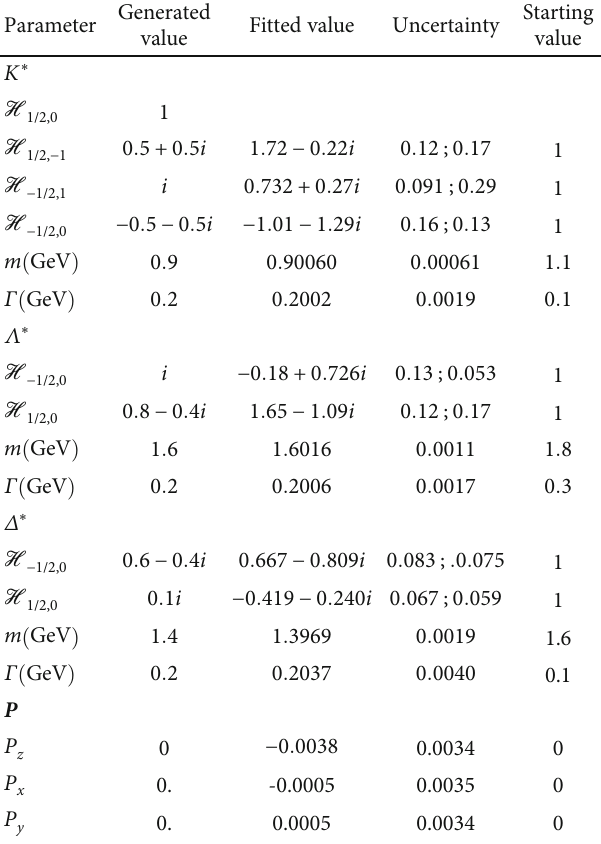
Table 3: Toy amplitude fi t study for zero polarisation. For helicity couplings, the two uncertainties are associated to their real and imaginary part separately. Generated Parameter Fitted value Uncertainty value